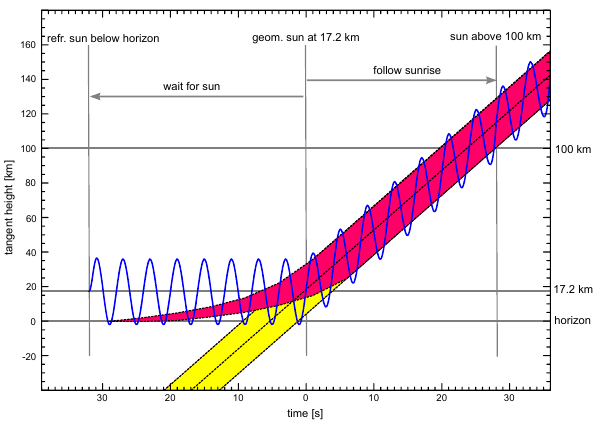
Fig. 2. Outline of the SCIAMACHY solar occultation measurement sequence. The yellow area indicates the geometrical position of the solar disk. The red area shows the visibility of the Sun, changed from the geometrical position by refraction in the Earth’s atmo- sphere. The sinusoidal line gives the viewing direction of the in- strument during the sequence, which is continued up to an altitude of 290km for the nominal scan (state 49). The shortened measure- ment stops scanning at 110km, followed by 2s pointing towards the Sun, adjusted by SCIAMACHY’s sun follower device (state 47).